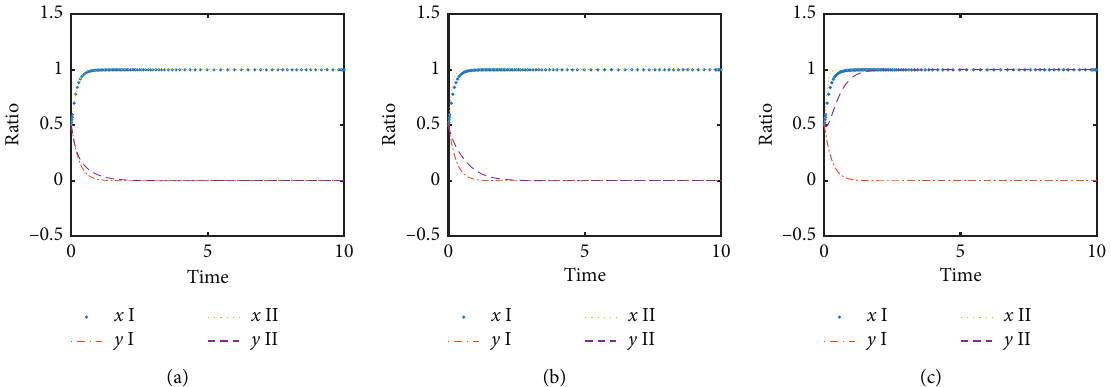
Figure 7: The influences of the trust degree of knowledge sharing groups on the evolution system. (a) λ (c) λ g � 2 , λ s � 0 .